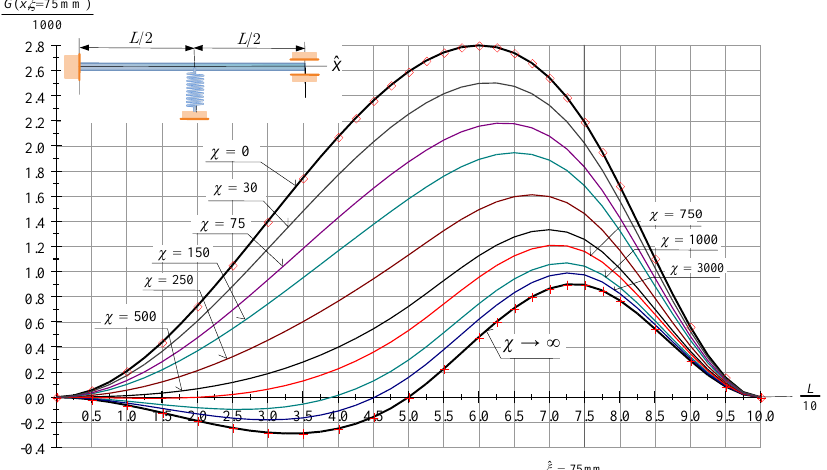
Figure 2. The Green function (the dimensionless vertical displacement field) of an FssF beam subjected to a dimensionless unit force at ξ =